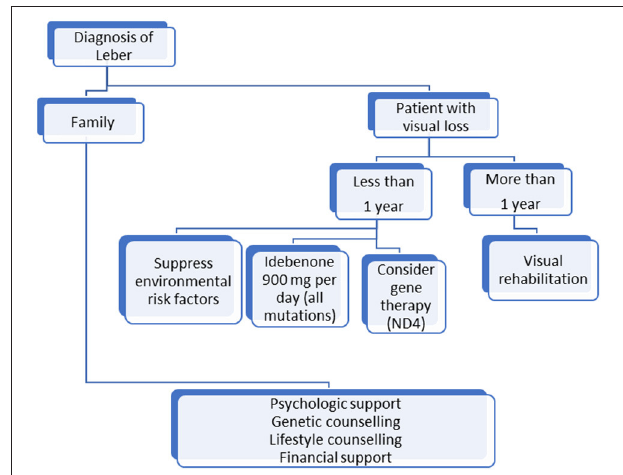
FIGURE 1 | Algorithm for management of patients with Leber optic neuropathy